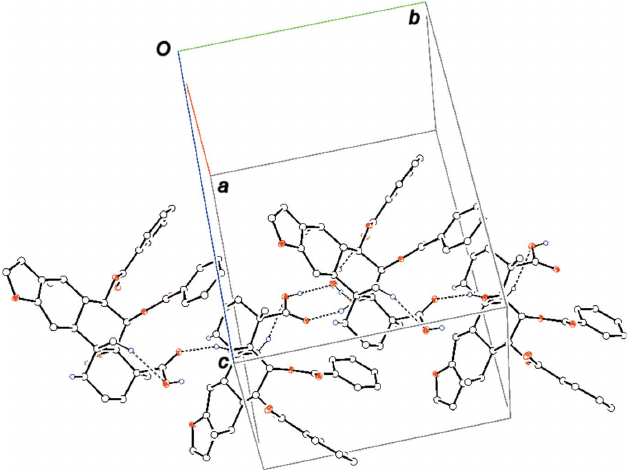
Figure 2 Partial packing diagram of the title compound showing the formation of a chain parallel to the b axis by O—H (cid:2)(cid:2)(cid:2) O hydrogen bonds (dotted lines). Intramolecular C—H (cid:2)(cid:2)(cid:2) O hydrogen bonds (dotted lines) are also shown. Hydrogen atoms not involved in hydrogen bonding are